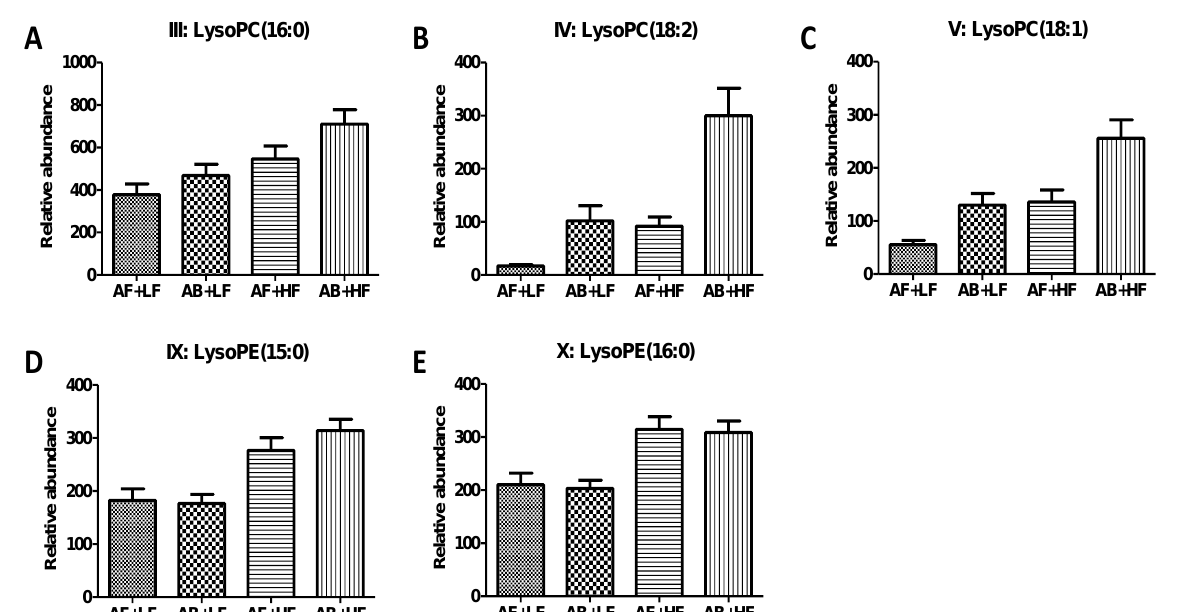
Figure 2. Effects of antibiotic and fiber treatments on lysophophoslipids in feces. ( A ) LysoPC(16:0), ( B ) LysoPC (18:2), ( C ) LysoPC (18:1), ( D ) LysoPE (15:0), ( E ) LysoPE (16:0). p- values are presented in